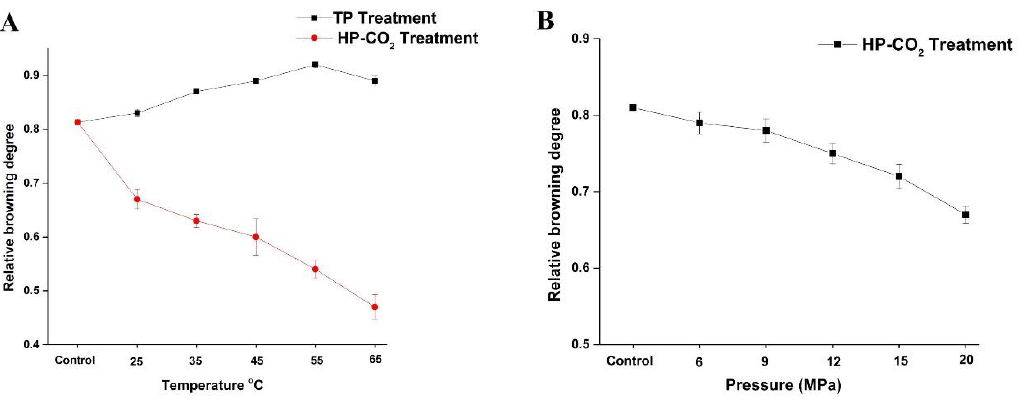
Figure 1. Changes in browning degree (BD) value of apple juice under thermal processing (TP) (25–75 ◦ C) and High pressure carbon dioxide (HP-CO 2 ) (25–65 ◦ C for 20 MPa) for 20 min ( A ) and HP-CO 2 treatment at di ff erent pressures (6–20 MPa, 30 ◦ C) for 20 min ( B ). Data presented as the mean ± SD (standard deviation).